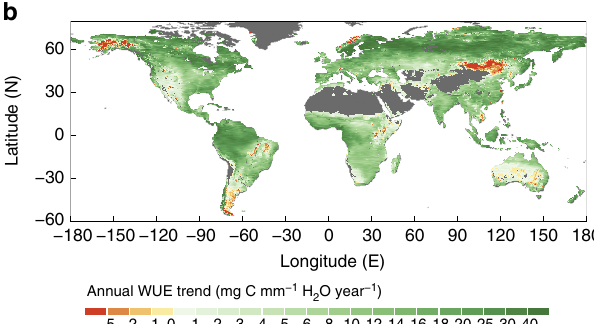
(Fig. 3a) but an increase in WUE (Fig. 3b), which is associated with a signi fi cant declining E trend in this region (Fig. 4a) outweighing the increase in WUE.